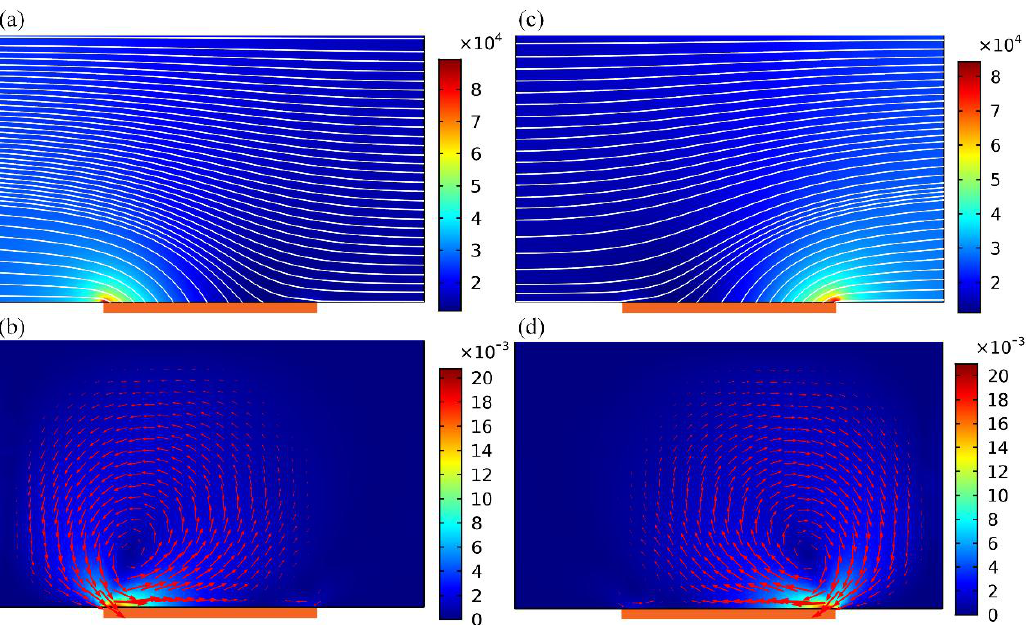
Figure 4. Simulation result of AC field-effect control on ICEO with non-neutral gate voltages in 3D electrode configurations, i.e. V G ≠ V D /2 = 4 V, reconfigurable vortex flow pattern can be induced across channel width direction. ( a , b ) When the gate polarity is negative V G < V D /2 ( V D = 8 V, V G = 2 V), electrochemical polarization becomes more significant adjacent to the left side of gate terminal, giving rise to a single large-scale ICEO vortex flow rotating counterclockwise, ( a ) a surface and streamline plot of the asymmetric electric field distribution (unit: V/m), ( b ) a surface and arrow plot of ICEO flow field, in which an anticlockwise eddy overwhelms the fluid motion within the entire fluidic channel (unit: m/s). ( c , d ) As GE is positively polarized V G > V D /2 ( V D = 8 V, V G = 6 V), gradients of both the electric field and flow field variables reverse in the horizontal direction with respect to ( a , b ), respectively. Most importantly, the rotating direction of ICEO vortex is inverted, and the clockwise electroosmotic micro-vortex near the right rim of GE governs the transverse electroconvection.